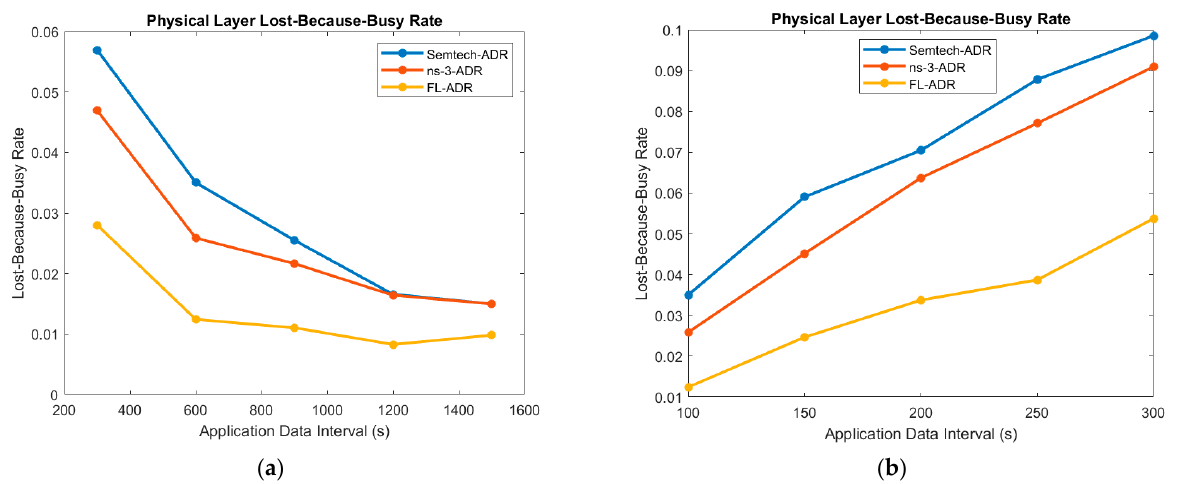
Figure 9. Lost-Because-Busy Rate: ( a ) data interval vs. avg. lost-because-busy rate; ( b ) no. EDs vs. lost-because-busy rate.